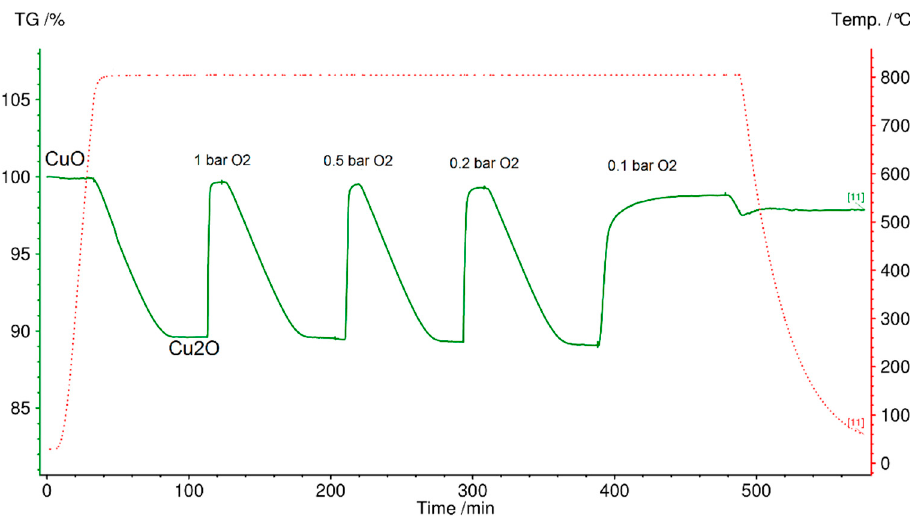
Figure 5. Experimental run for oxidation and reduction of Cu 2 O and CuO, respectively, at 800 °C and different oxygen partial pressures in the simultaneous thermal analysis (STA).